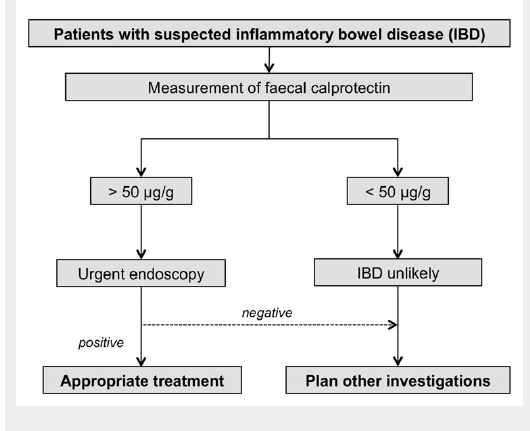
A diagnostic algorithm for the evaluation of patients with suspected inflammatory bowel disease that includes faecal calprotectin measurement before endoscopy.